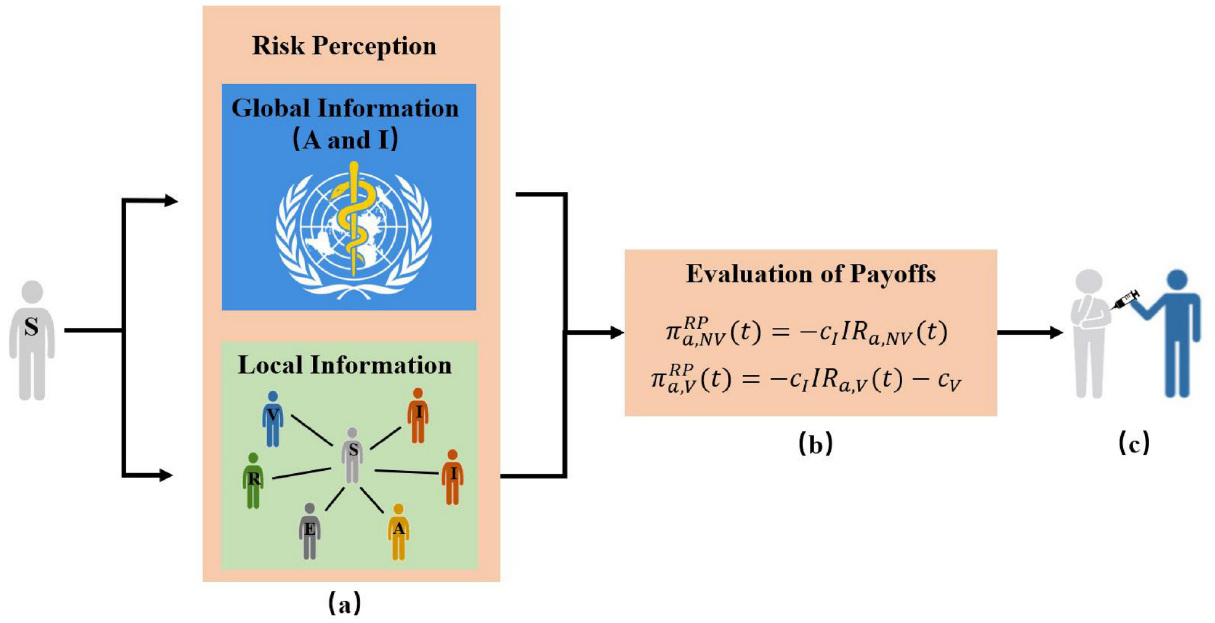
Fig 2. Schematic representation of the Risk Perception ( RP ) vaccination strategy under different information sources. Individuals decide to be vaccinated by calculating the payoffs with or without vaccination based on infection risk perception, where the infection risk is perceived by global information released by Public Health Bureau or local information from first-order neighbors. (a) The information sources obtained by individuals is used to perceive the infection risk; (b) Evaluation of payoffs for unvaccinated and that of vaccinated individuals at time t ; (c) Individuals determine to take the vaccinate or